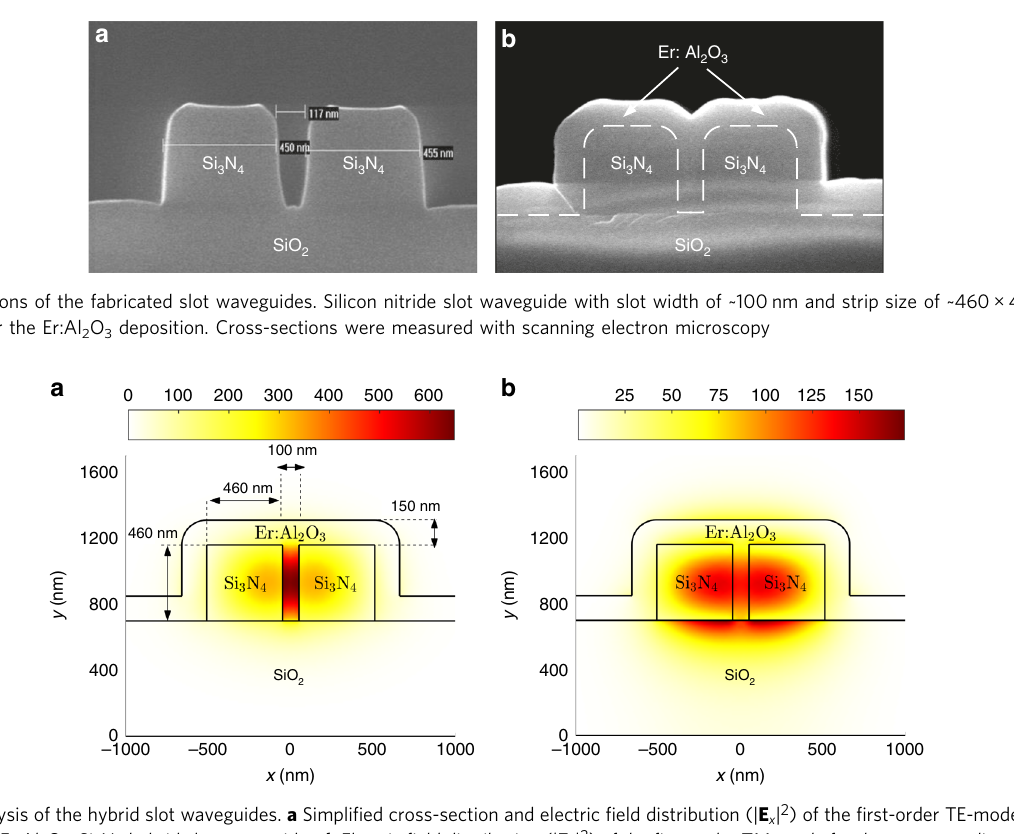
¼ 1 : 466, n ¼ 1 : 650, n ¼ 1 : SiO 2 Er:Al 2 O 3 Si 3 N 4